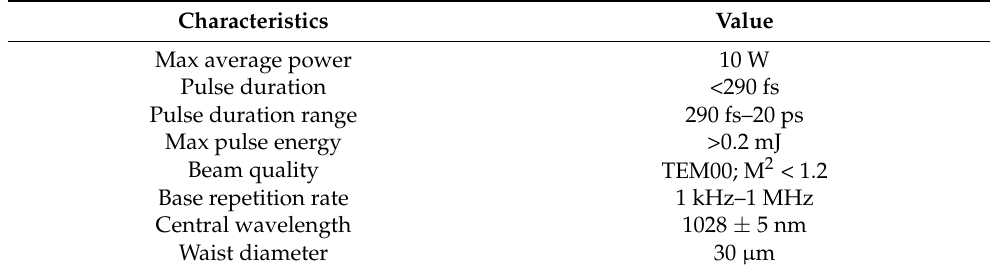
Base repetition rate 1 kHz–1 MHz Central wavelength 1028 ± 5 nm Waist diameter 30 µ